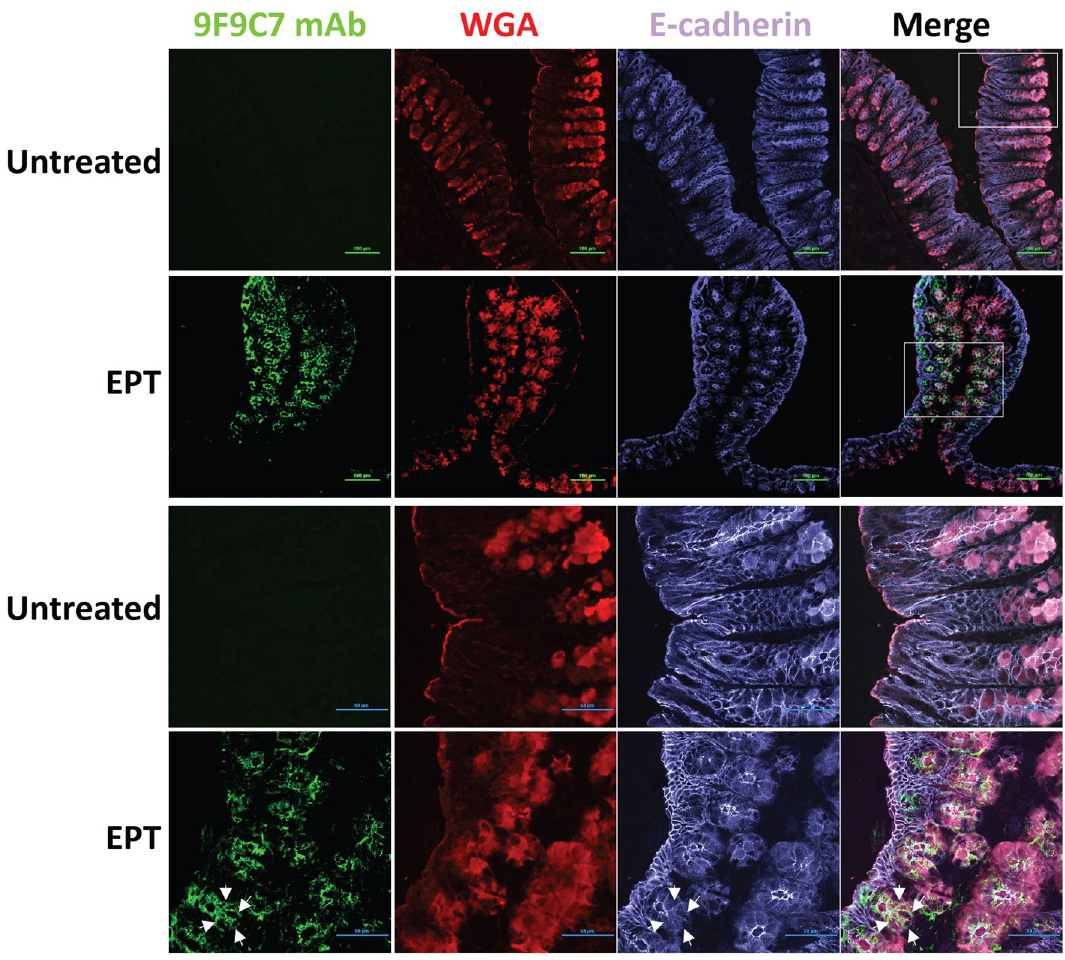
Figure 7. IHC detection of EPICERTIN bound to the surface epithelial cells of mouse colon tissue. Confocal laser scanning microcopy of colon tissues from mice treated or left untreated with EPICERTIN by oral gavage. Colon tissues were collected from EPICERTIN-dosed mice at 0, 3, 6, 12, and 24 h after oral administration or from untreated animals and embedded in OCT compound for cryosectioning. Seven microns thick tissue sections were made and stained with 5 μg/mL Pheno Vue Fluor 594-WGA, 2 μg/mL anti-E-cadherin and 2 μg/ mL anti-CTB (FITC-9F9C7 mAb). Representative confocal images of an EPICERTIN-treated animal tissue isolated at 24 h and a tissue from a control untreated animal are shown. White arrows indicate distribution of EPT at the plasma membrane of individual colon crypt epithelial cells. Images were collected with a Nikon A1R Confocal laser scanning microscope using 20 × (top panel) and 60 × (lower panel) magnification lenses with appropriate channels and the data processed with the NIS Elements imaging software. Areas delineated by dotted line squares in panel A correspond to high magnification images shown in lower